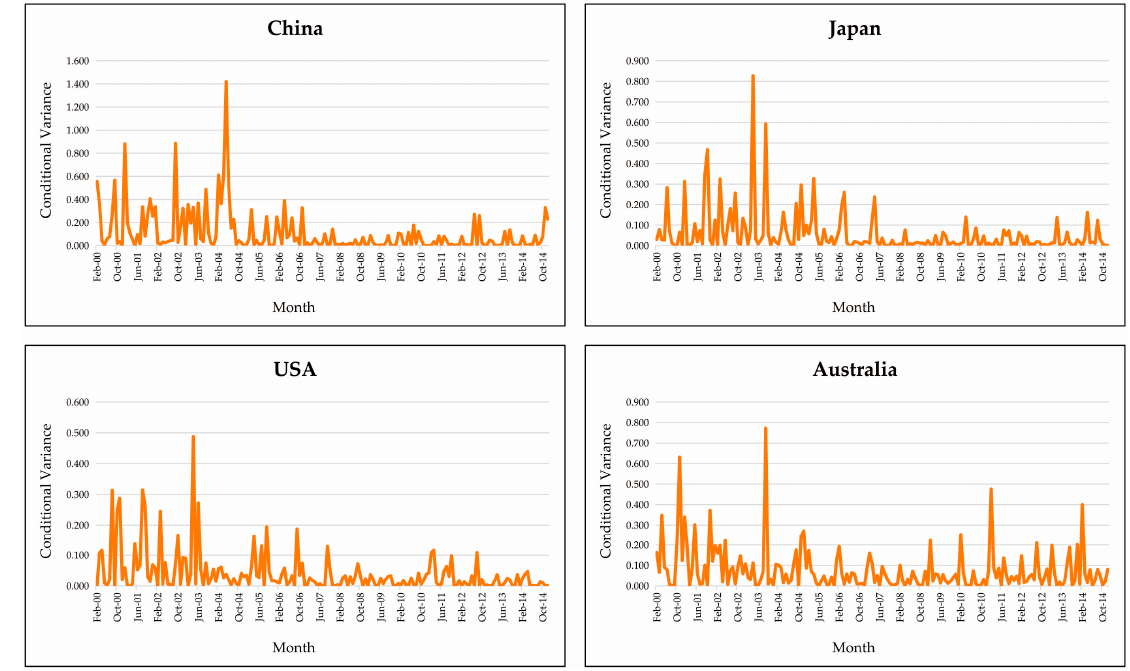
Figure 4. Estimated conditional variances (selective four